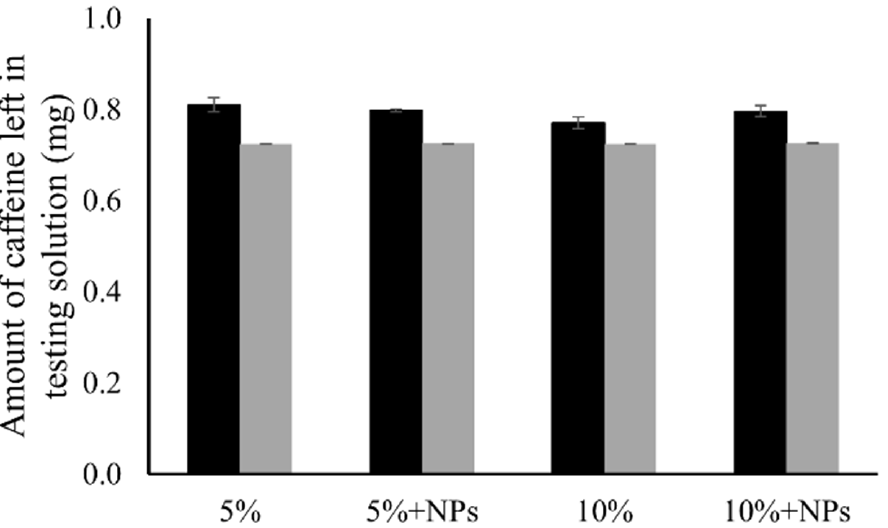
Figure 7. The measured amount ( ) and calculated amount ( ) of caffeine left in the testing solutions after 48 h test for the 5% PCL membrane, 5% PCL membrane with NPs, 10% PCL membrane and 10% PCL membrane with NPs.